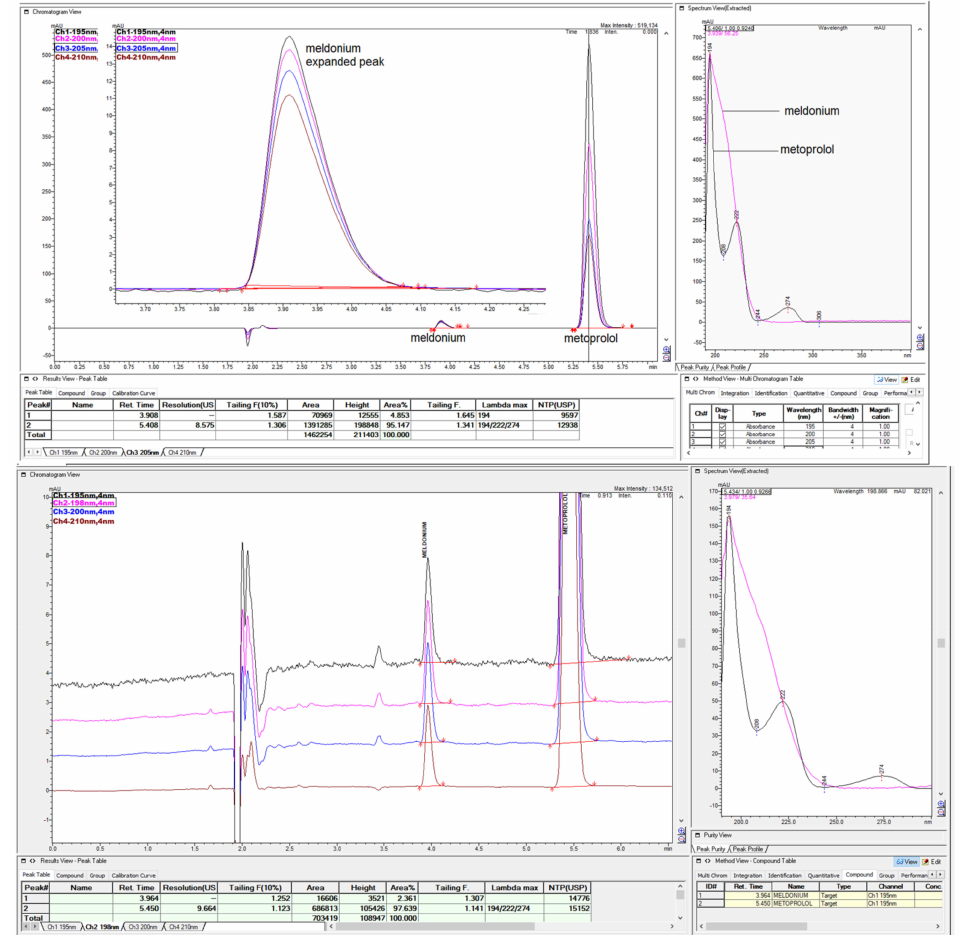
Figure 20. Chromatogram with 50% ACN and 50% diluted TFA, with full size chromatogram below and inserted expanded view of meldonium peak in zoomed scale above, monitored and overlaid at 4-channels with 4 different wavelengths. The right side of figure contains extracted UV spectrums of meldonium and metoprolol. The system suitability of chromatogram can be seen in the table below. The bottom figure illustrates mobile phase noises from upper